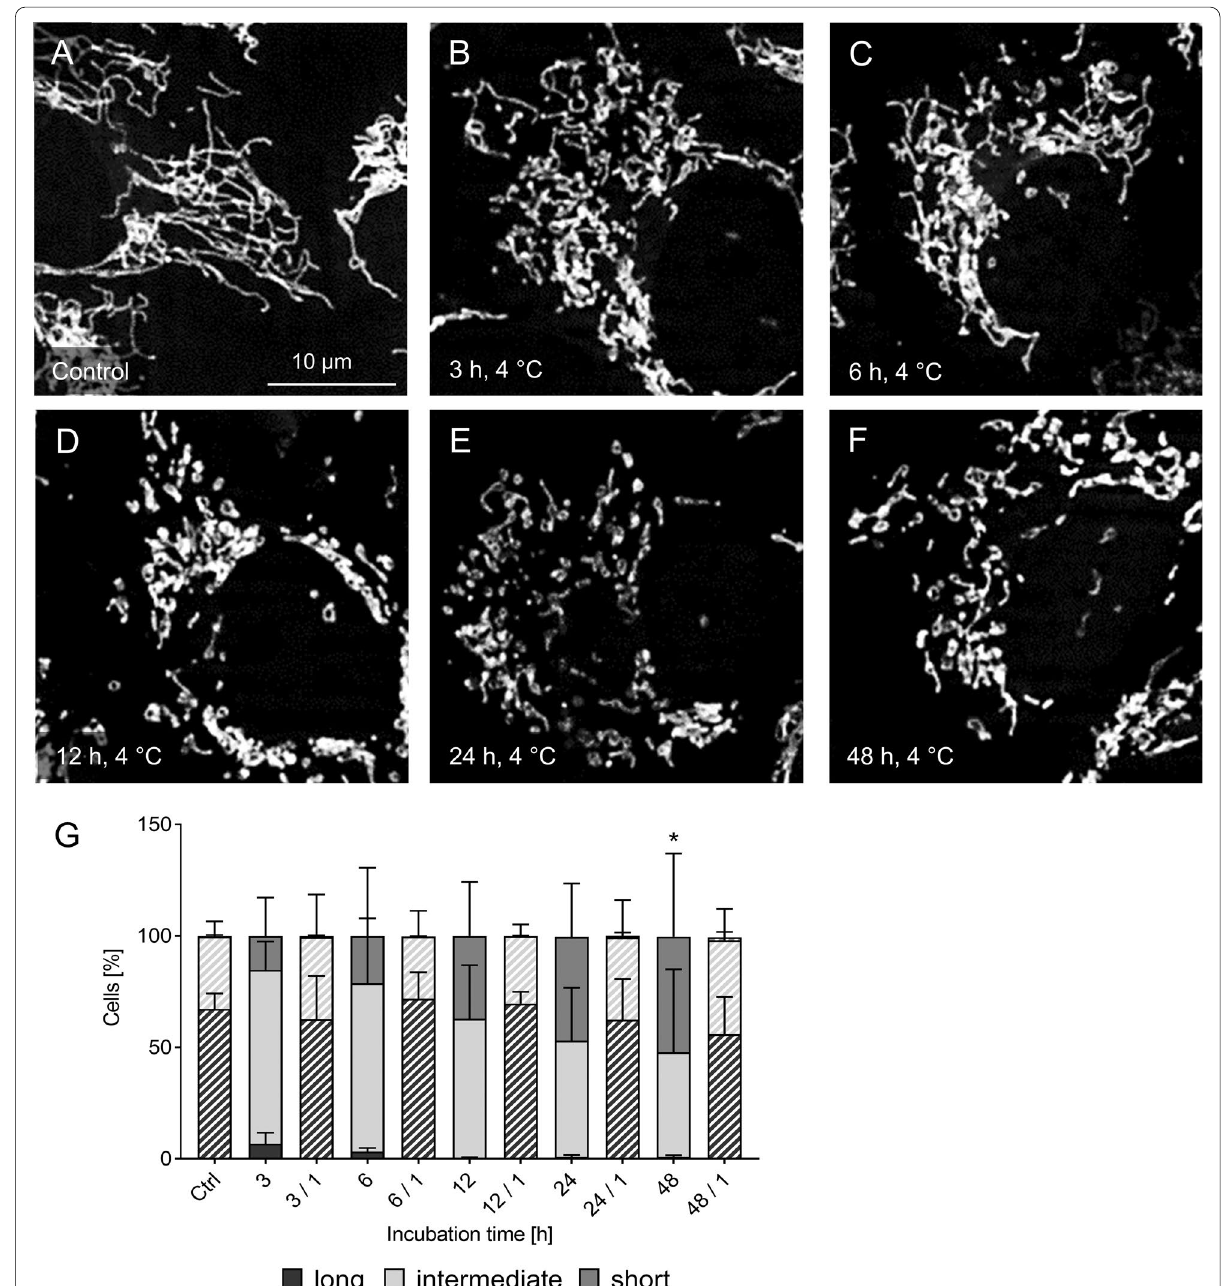
Fig. 2 Time dependence of cold-induced mitochondrial fission. Cultured porcine aortic endothelial cells ( A ) were exposed to hypothermia for 3 h ( B ), 6 h ( C ), 12 h ( D ), 24 h ( E ) and 48 h ( F ). Mitochondria were stained by MitoTracker Red and documented using fluorescence microscopy (λ exc. 546 6 nm, λ em. 590 nm). Representative figures of n 4 experiments. For quantification ( G ) cells, incubated at 4 °C for the indicated time = ± ≥ = (i.e. 3 h) and rewarmed for 1 h at 37 °C (e.g. 3/1), were categorised in cells with predominantly short, intermediate or long mitochondria by a person blinded to the experiment. Warm/rewarming conditions are shown hatched. Means SD of n 4 experiments. *Significant difference of long ± = mitochondria compared to control (p ≤